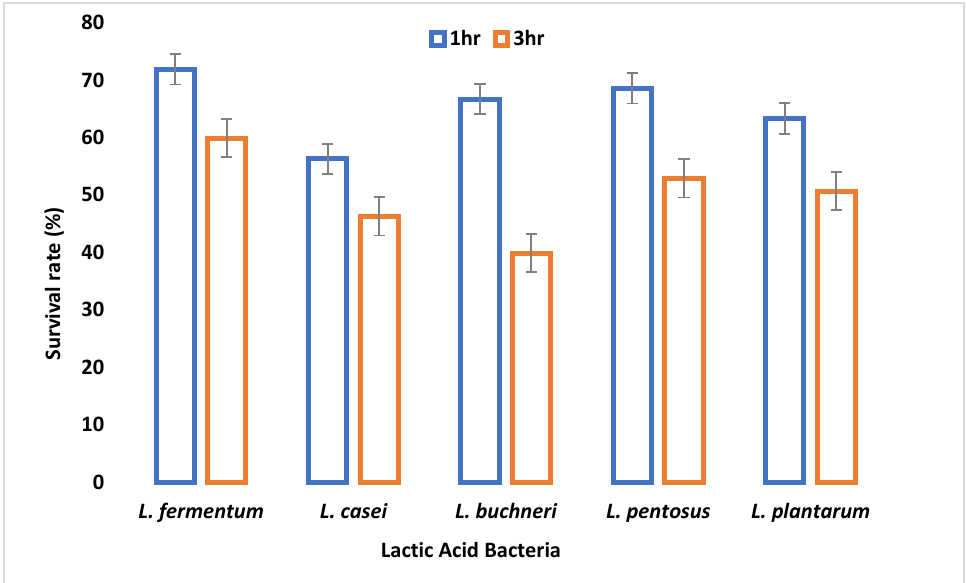
Figure 2. Survival of the lactic acid bacteria isolates at pH 2.5 after 1 and 3 h, respectively. All isolates survived at pH of 2.5 but L. fermentum was the most resilient even after 3 h.